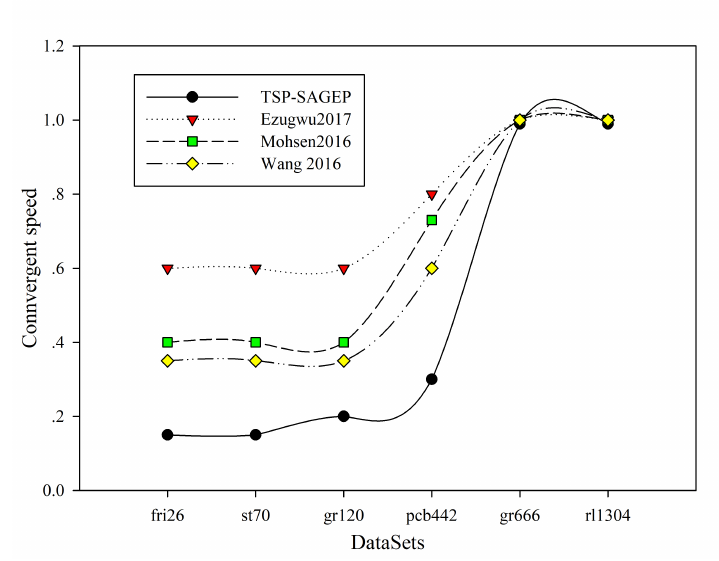
Figure 6. Comparison of convergent speed among four algorithms for six